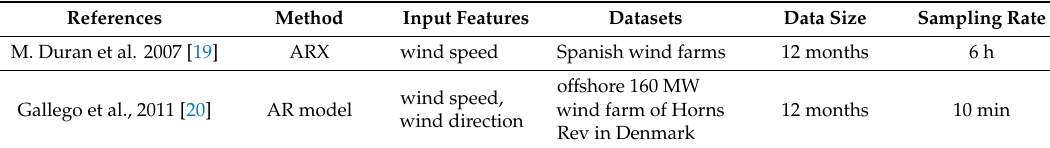
Table 2. Time series wind power prediction